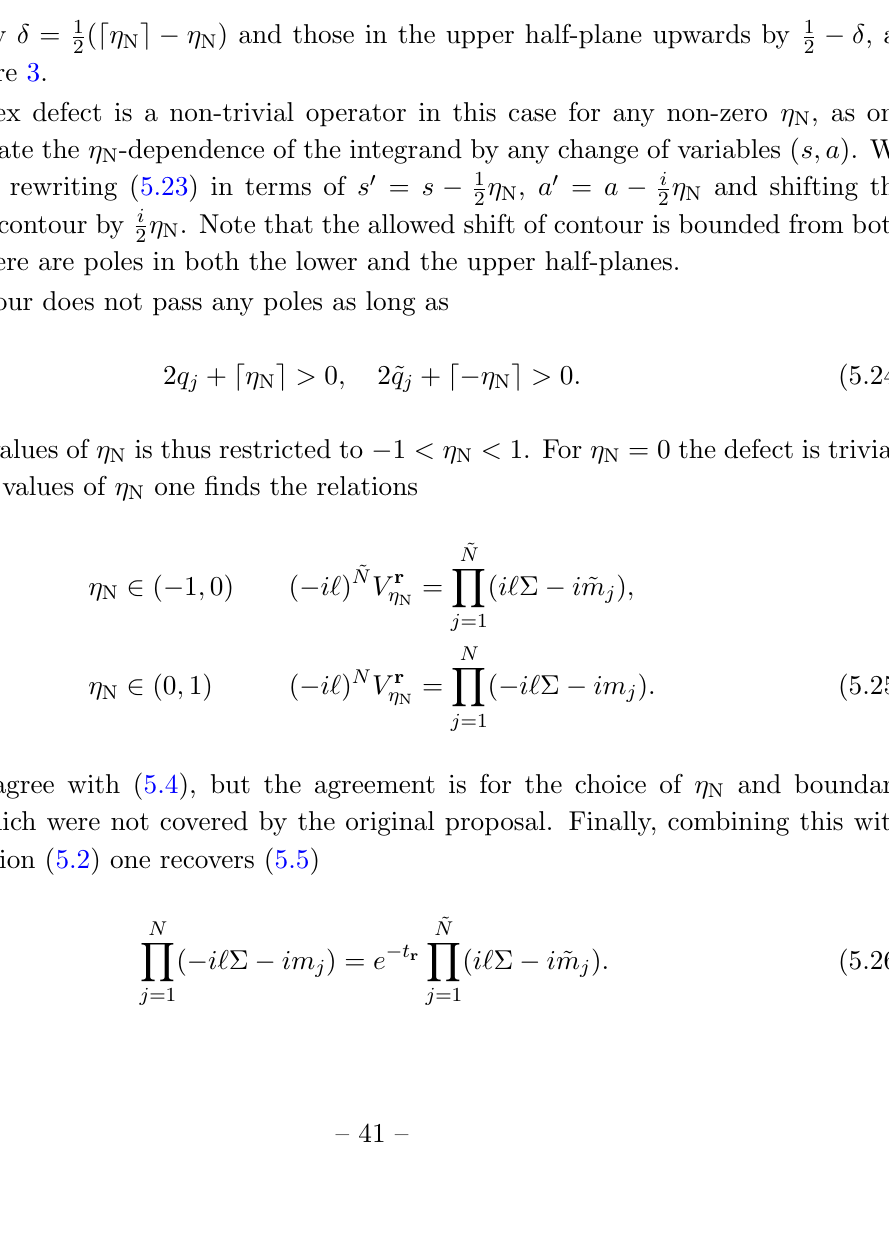
(cid:0) (cid:14) . We shift the integration 2